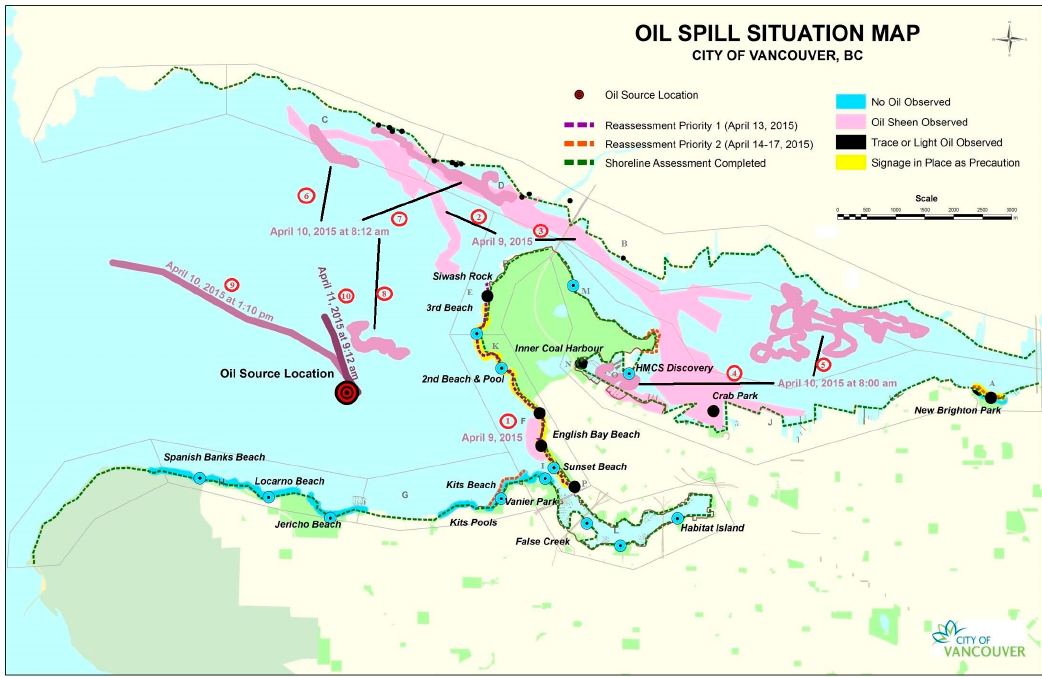
Figure 2. The M/V Marathassa oil spill situation map (map provided by the City of Vancouver, BC). This map shows the observed spilled oil trajectory on the water surface and the contamination on the shoreline in the English Bay and Vancouver Harbour from 8 April 2015 to 10 April 2015 [8]. Areas with oil sheen are numbered as 1–10, and contaminated shoreline areas are labeled as